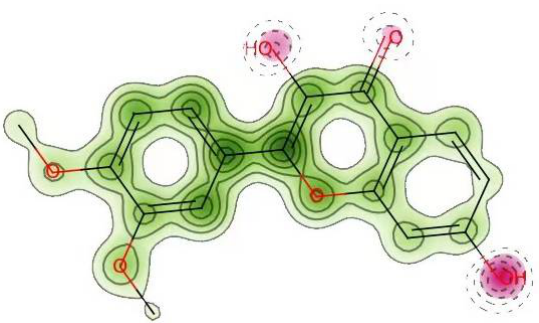
Figure 8. Cardiac toxicity of isolated flavone derived from pred-hERG in a map format.